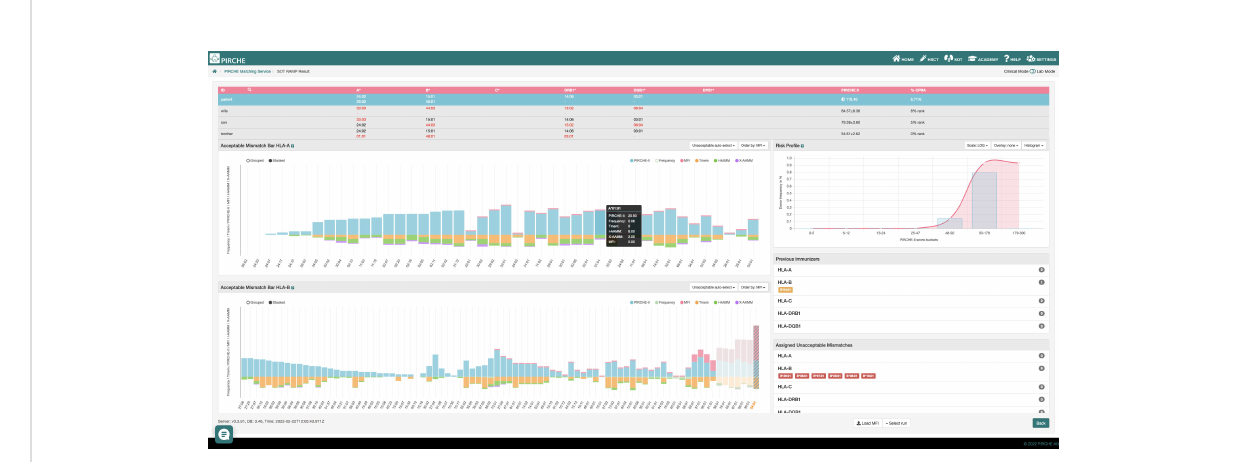
FIGURE 12 PIRCHE Risk and Acceptable Mismatch Pro fi le including PIRCHE-II epitope scores (blue bars), mean fl uorescence intensities of imported single antigen bead assays (pink bars), shared T-cell epitopes with previous immunizers (orange bars), allele frequencies (pale green bars), interlocus Snow fl ake scores (purple bars) and intralocus Snow fl ake scores (dark green